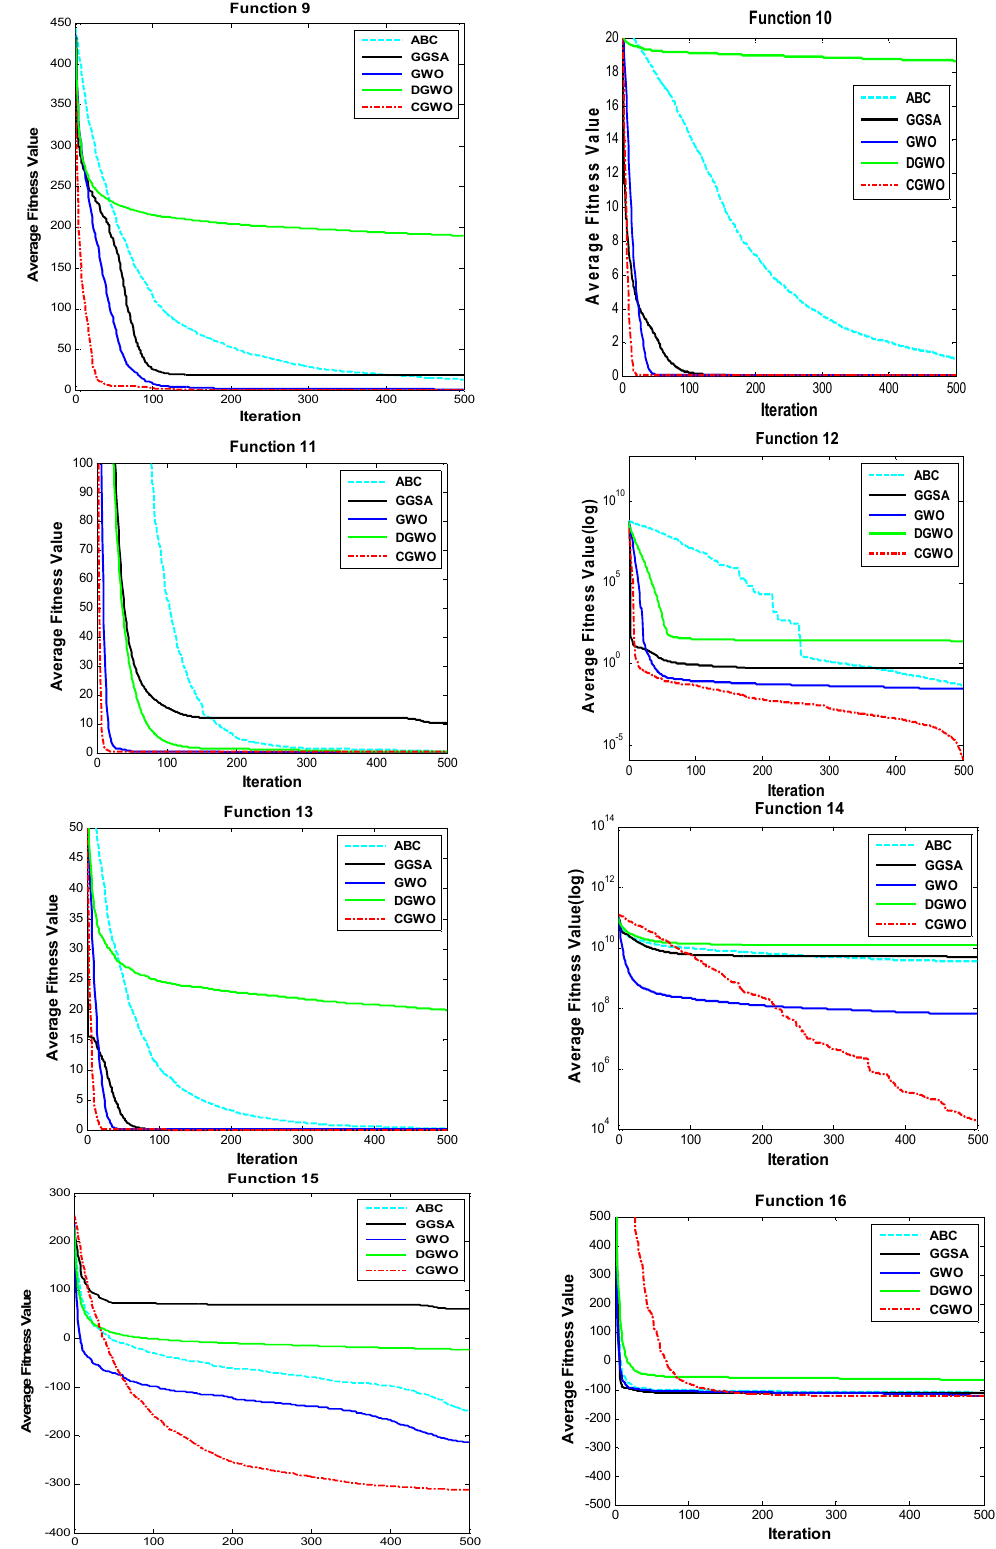
Figure 3. Convergence behavior of ABC, GGSA, GWO, DGWO, and CGWO on multimodal functions with Dim = 30.